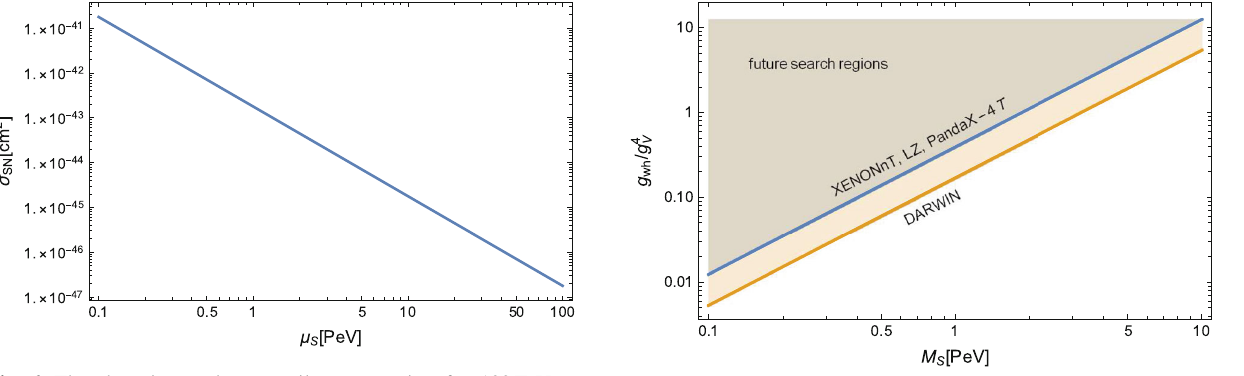
Fig. 8 Sensitivities of future direct search experiments for the skyrmion coupling parameter g w h / g 4